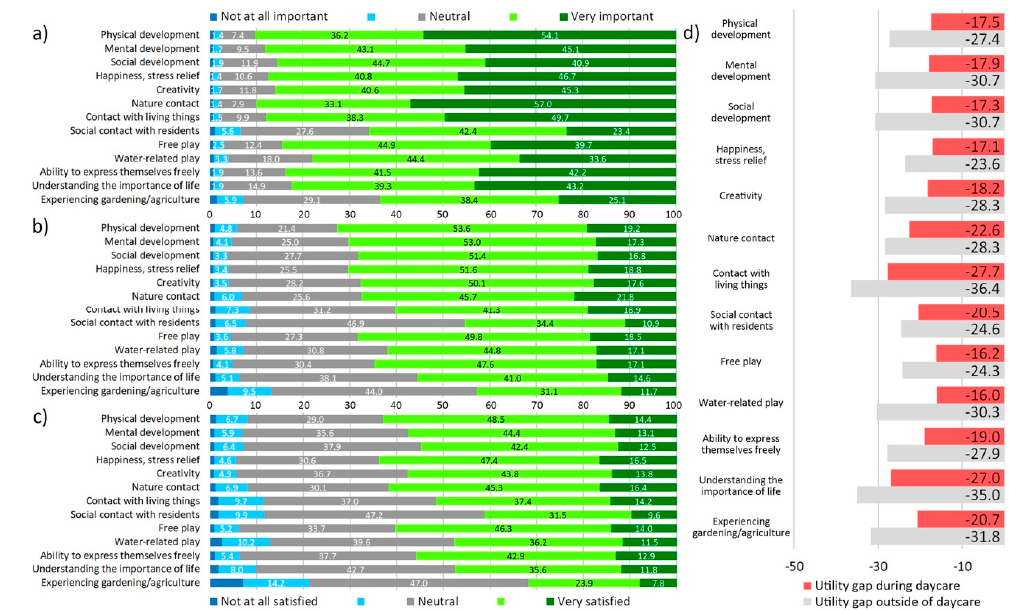
Figure 6. DC parents perception of GS: ( a ) importance of outdoor play for children aged five or under in regard to ... , ( b ) satisfaction with greenspace regularly used during daycare in regard to ... , ( c ) satisfaction with greenspace regularly used outside of daycare in regard to ... , ( d ) utility gap of greenspace used during and outside of daycare (satisfaction-importance).